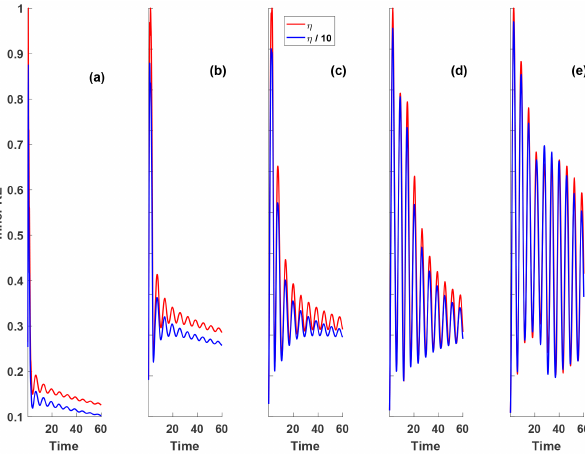
Figure 6. Long-time simulations comparing the differences in the Figure 7. The difference in total inner kinetic energy between our geostrophic state for negative and positive initializations. For both original amplitude cases and cases where the amplitude has been w 0 and Ro = 1 simulations f = 2 f 0 , w = 1 . Panel (a) presents the 2 2 reduced by a factor of 10. The reduced cases have then been linearly long-time time series of vertically integrated kinetic energy in the scaled to account for this amplitude change. The original energies geostrophic state for both cases. Panel (b) shows the base-10 log- are shown in red, while the reduced ones are in blue. Discrepancies arithm of the geostrophic state kinetic energy for both cases after w 0 between the two cases are due to nonlinear effects. (a) w = 1 the packet has been ejected. Panels (c) and (d) show the shaded dis- 4 w 0 ( Ro = 1), (c) w = w 0 ( Ro = 0 . 5), (d) w = ( Ro = 2), (b) w = 1 tribution of kinetic energy in the geostrophic state along with con- 2 2 w 0 ( Ro = 0 . 25), and (e) w = 4 w 0 ( Ro = 0 . tours of constant density, for a negative and positive initial polarity respectively.